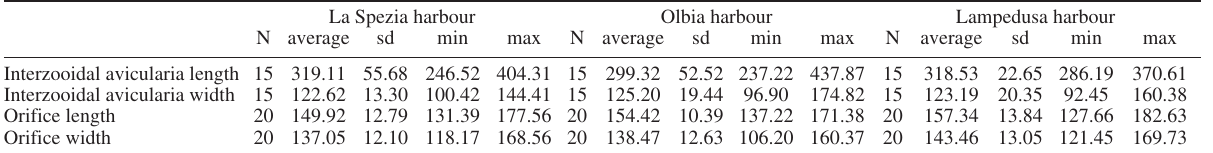
5. – Celleporaria brunnea specimens from the western Mediterranean Sea: (A, B) close-up of two interzooidal avicularia; (C) zooids with Table 2. – Interzooidal avicularia and orifice dimensions (μm) of Celleporaria brunnea specimens from the harbours of La Spezia, Olbia and Lampedusa. N, number of individuals; sd, standard deviation; min, minimum value; max, maximum value.